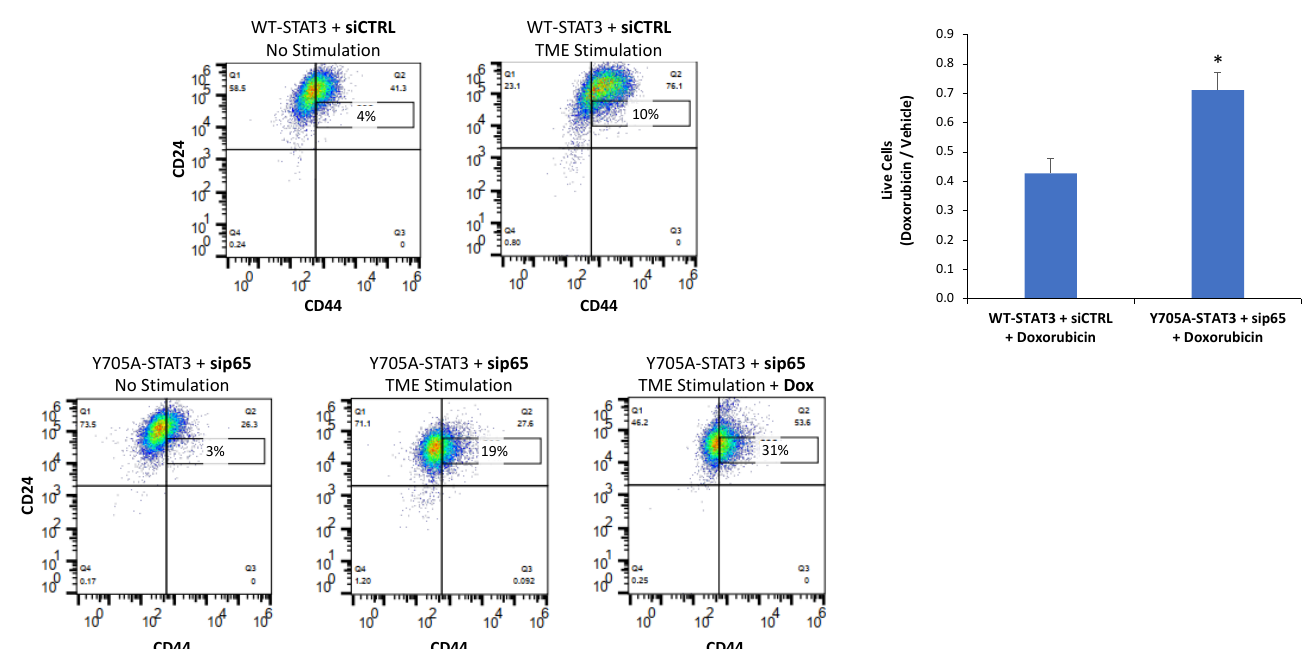
Figure 13. Upon TME Stimulation, the joint use of mutated Y705A-STAT3 and p65 knock-down leads to increased CSC resistance to doxorubicin in HR+/HER2 − breast cancer cells: MCF-7 cells over- expressing WT-STAT3 or Y705A-STAT3 were transfected with sip65 or siCTRL. The cells were exposed to TME Stimulation (Concentrations as described in Figure 1), or treated by vehicle control (“No Stimulation”) for 96 h. During TME Stimulation or treatment by vehicle, the cells were also exposed to 0.5 µ M doxorubicin (Dox), based on titration analyses. ( A ) The contents of CSCs were determined following 96 h of TME Stimulation, as described in Figure 1. CSC levels are presented in a narrower “window” than in previous figures, because doxorubicin induced elevation in autofluorescence of the cells, as reported previously by others [70]. The results are from a representative experiment of n = 3, showing similar results. ( B ) Average ± SD of n = 3 experiments demonstrating fold change between doxorubicin-treated and control cells treated by vehicle, based on cell counts using exclusion dye (trypan blue). * p <